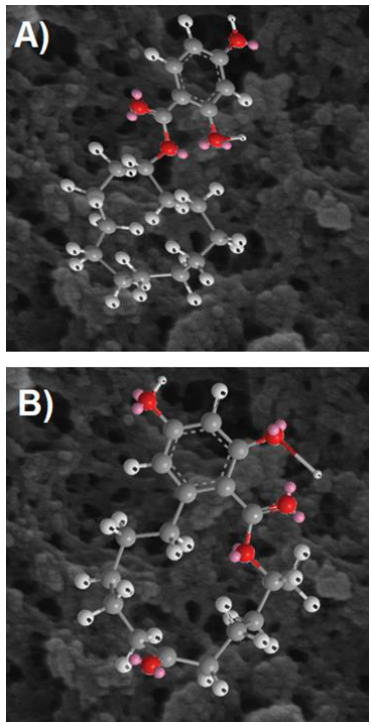
Figure 13. CDHB (a) structural similarity to ZEA (b) in the molecularly imprinted polymer on the Figure 13. CDHB ( a ) structural similarity to ZEA ( b ) in the molecularly imprinted polymer on the background of images (×100,000) obtained by scanning electron microscopy (SEM). background of images ( × 100,000) obtained by scanning electron microscopy